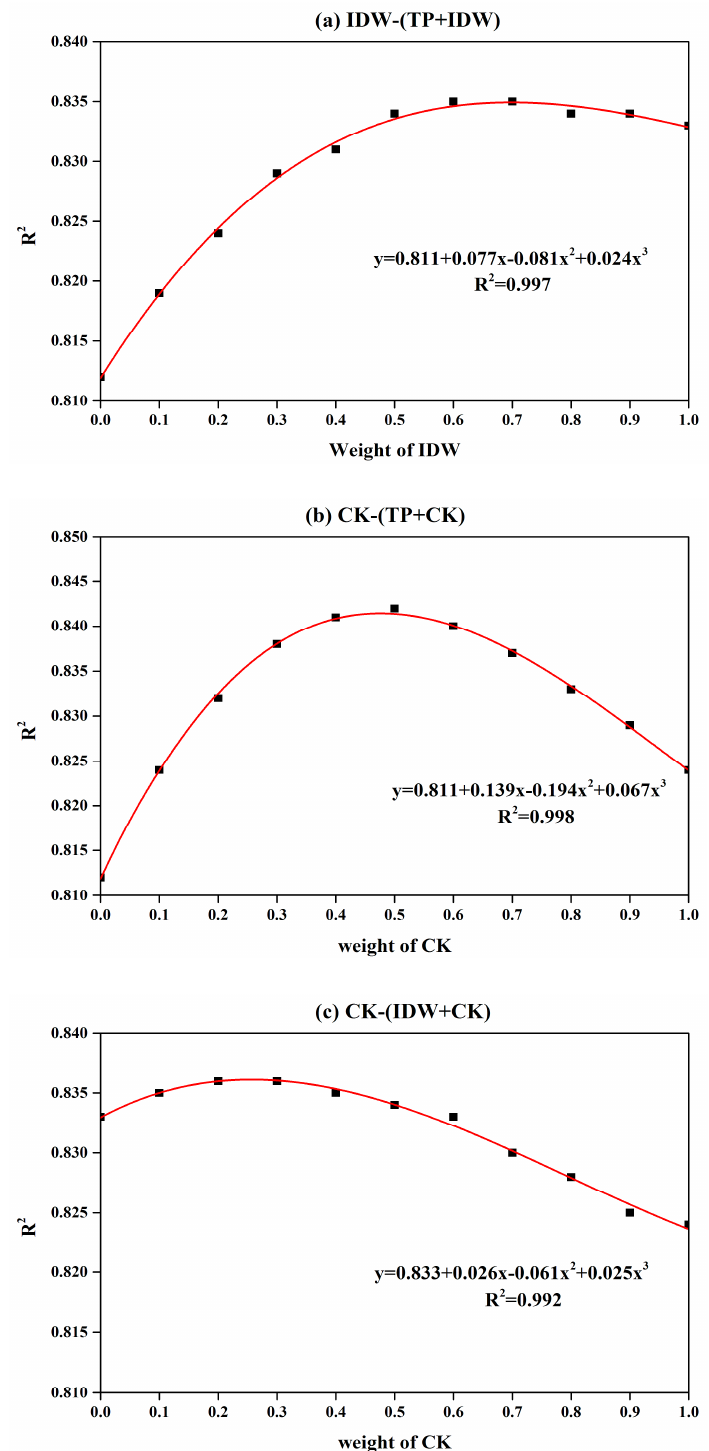
Figure 4. Relationship between the weight of one method’s estimate in the combination method with the performance of streamflow prediction accuracy R 2 in 2012. ( a ) IDW-(TP+IDW), ( b ) CK-(TP+CK), ( c ) CK-(IDW+CK).